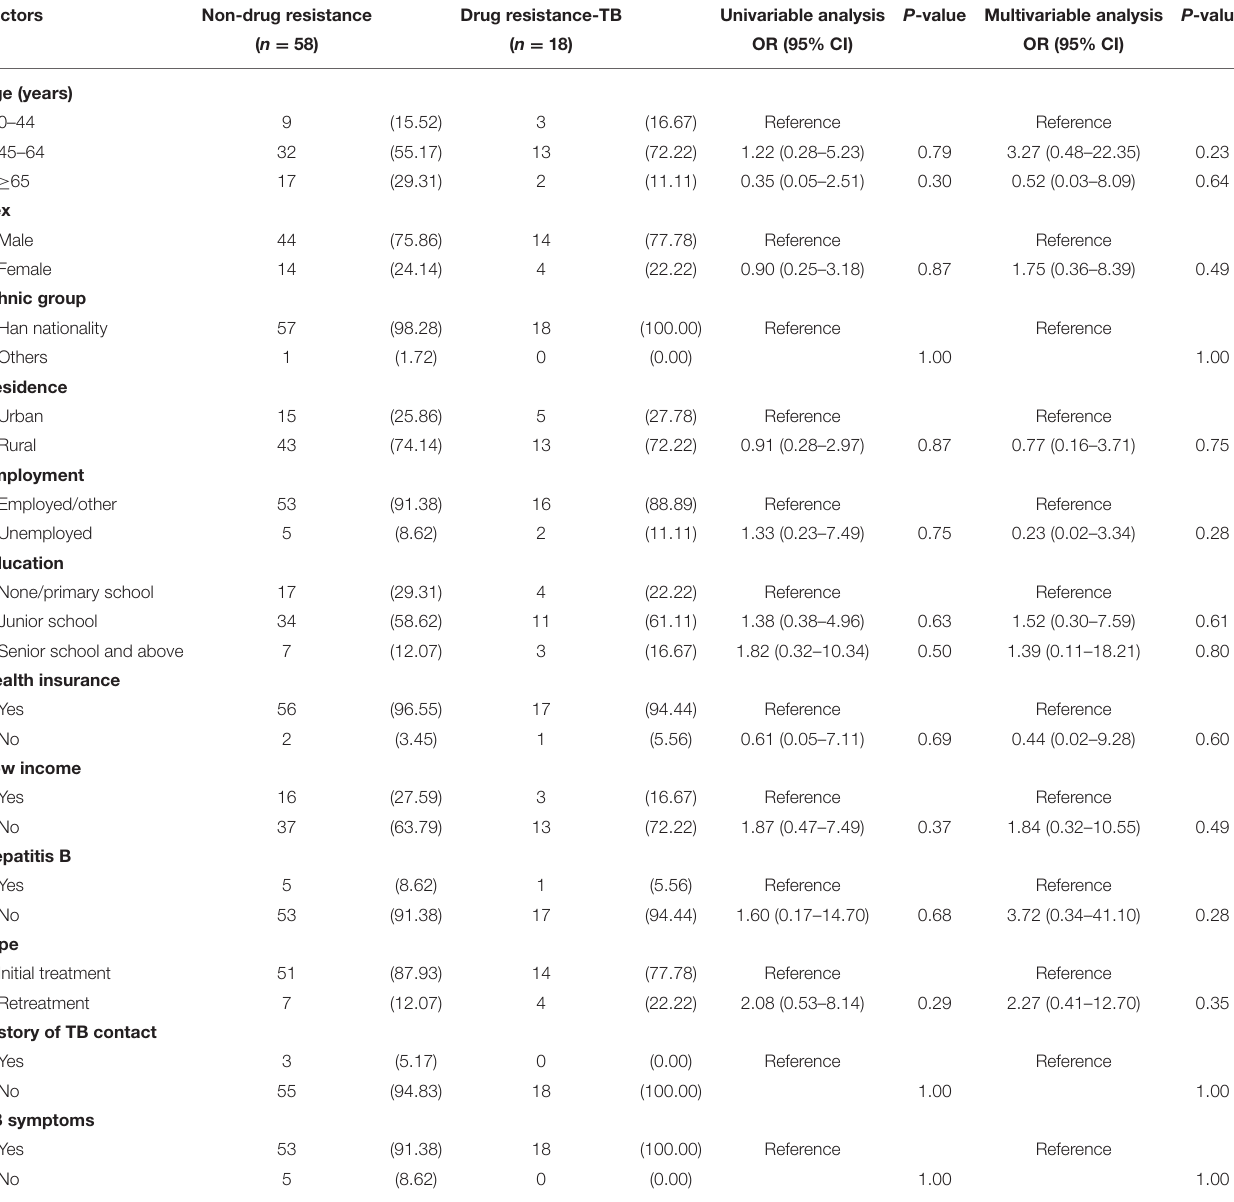
TABLE 3 | Risk factors of drug resistance among TB-DM